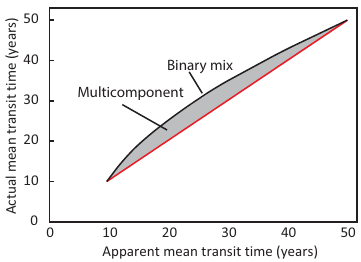
Figure 8. Impact of aggregation on calculated mean transit times. Apparent mean transit times are calculated from the 3 H activities of mixtures of waters with actual mean transit times of between 10 and 50 years using the exponential-piston flow model with an EPM ratio of 0.33. Actual mean transit times are calculated from the weighted average mean transit times in the mixed water. The binary curve rep- resents variable mixtures of the two end-members, the shaded field represents mixtures of multiple waters with mean transit times be- tween 10 and 50 years. The red line represents agreement between apparent and actual mean transit